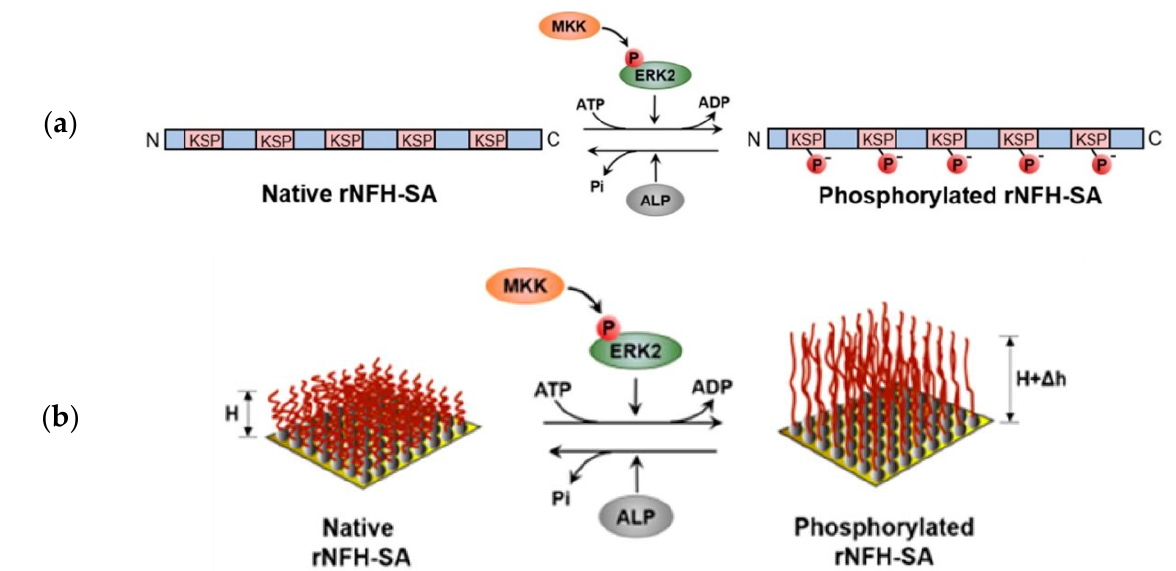
Figure 3. Enzymatic phosphorylation of: ( a ) recombinant heavy subunit of neurofilaments (NFH-SA) and; ( b ) immobilized recombinant heavy subunit of neurofilaments (NFH-SA) brushes using a two-kinase process involving treatment with ERK2 preactivated with MEK. Reprinted with permission from [44]. Copyright (2018) American Chemical Society.